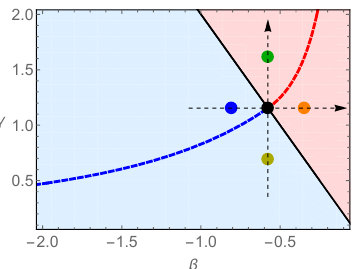
Figure 11. Allowed region of ( (cid:12); (cid:13) ) for (cid:11) = 0. In (cid:12)gure 12 we show the resistivity for the parameters corresponding to the dots. See the items 1-5 in sec, 5.2 for the meanings of colors, lines, and dots.